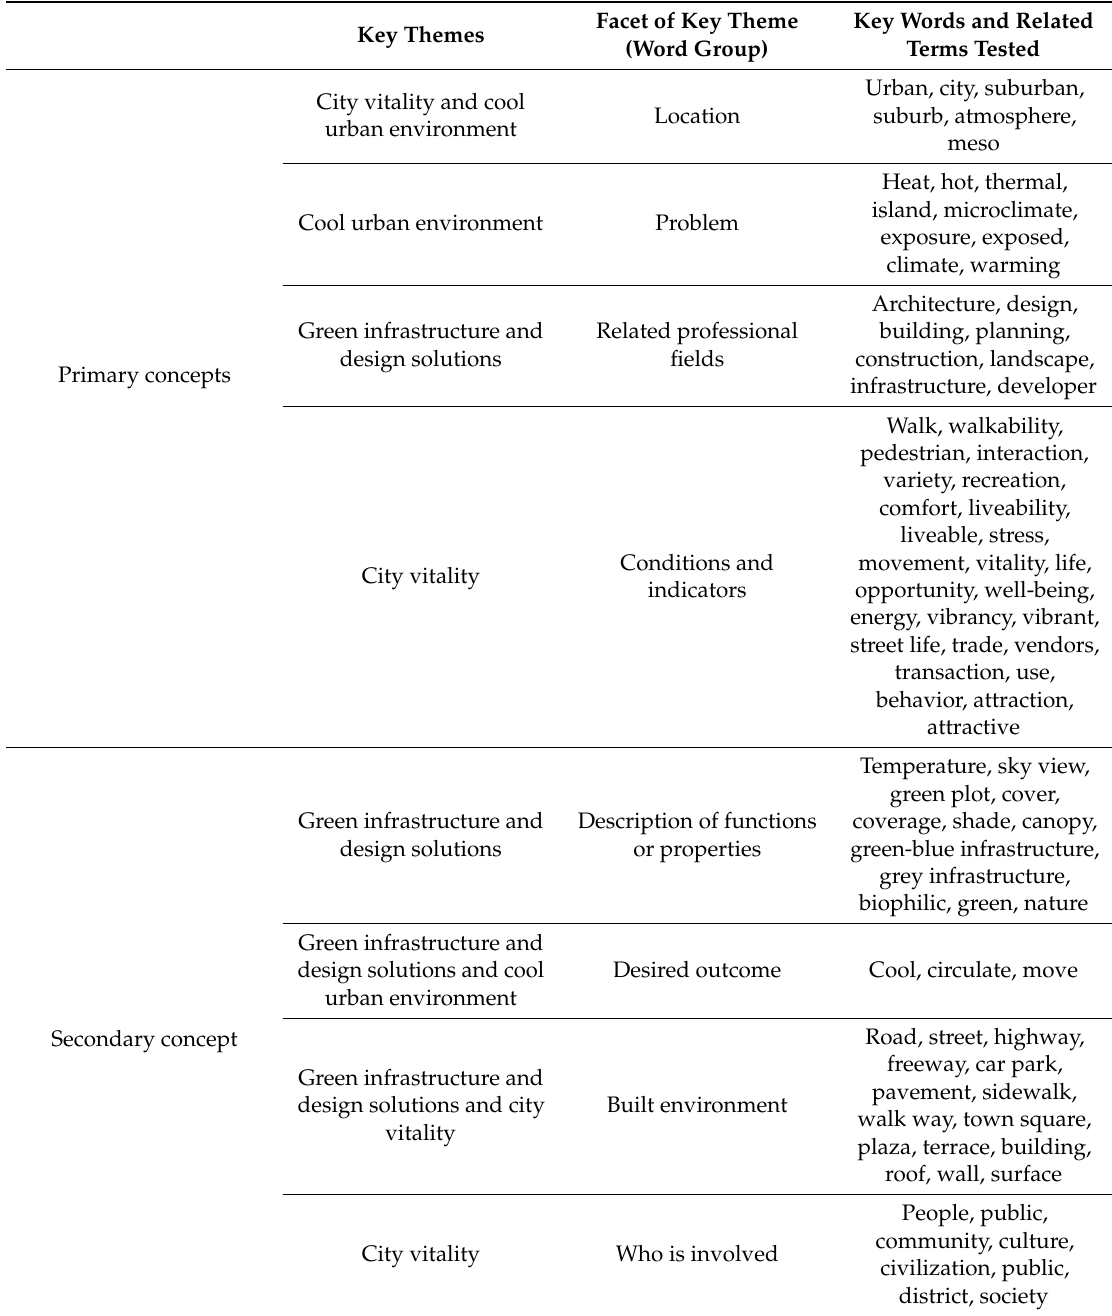
Table 1. Concept grid: key themes, key words tested for inclusion, and final search strings chosen as search